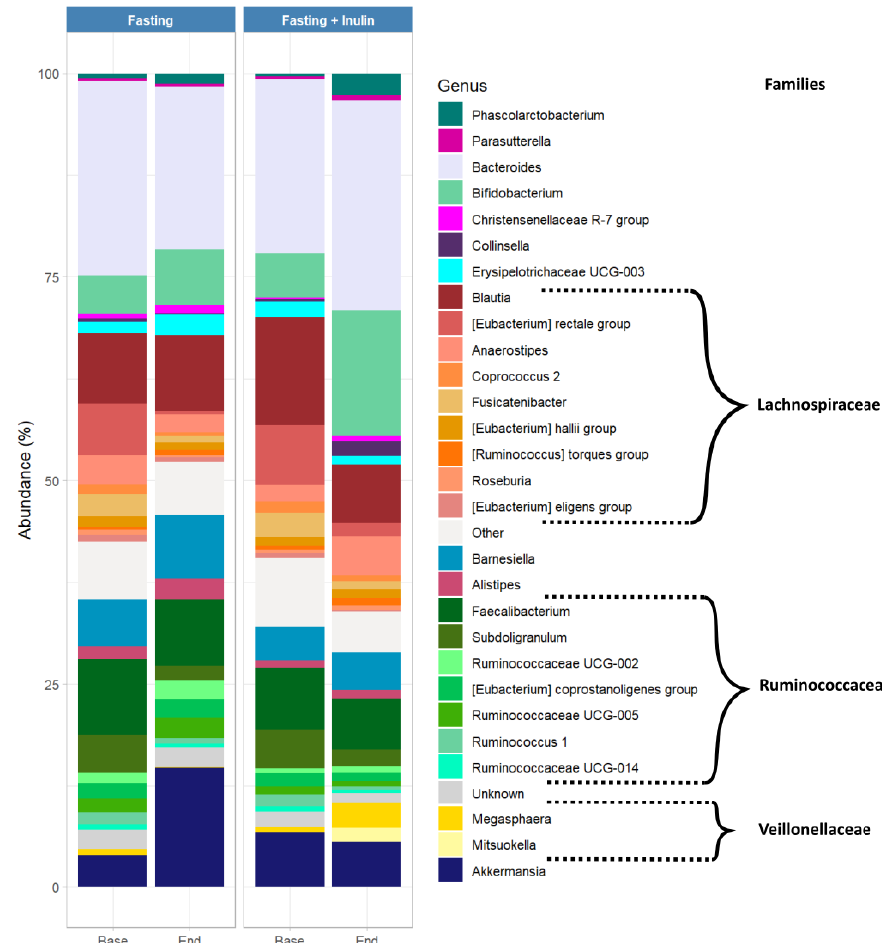
Figure 4. Bacterial composition of aggregated gut microbial samples before and after fasting inter- ventions and inulin consumption. Relative abundance of the most abundant genera. Genera from the same family are grouped next to each other by decreasing level of abundance and colored with a similar shade. Names of the corresponding families are indicated by brackets.